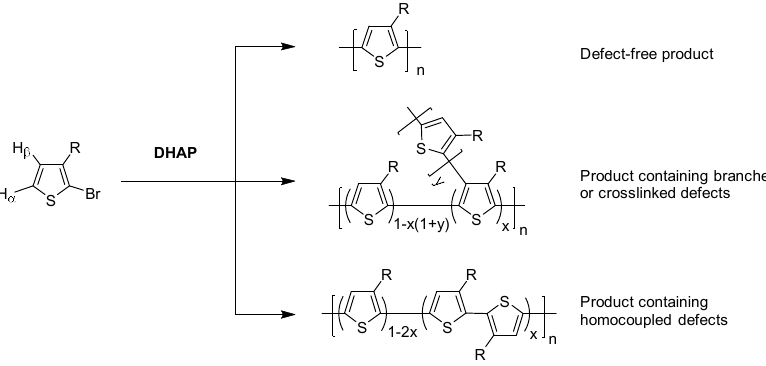
Figure 1. Direct (hetero)arylation polymerization (DHAP) of a 2-bromo-3-alkylthiophene, showing the potential for forming homocoupling and branching defects.